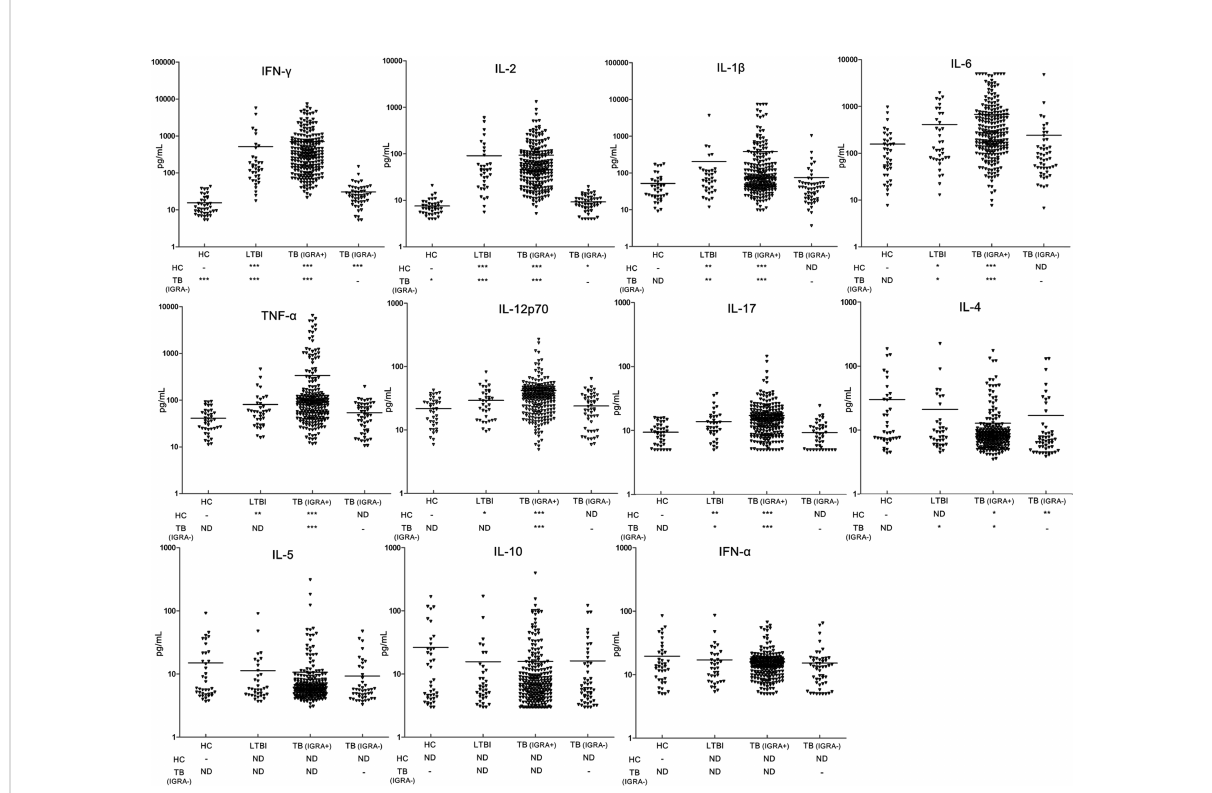
FIGURE 1 Comparison of the concentration of multiple cytokines induced by MTB-speci fi c antigens between groups. Levels of cytokines were detected by using Luminex xMAP technology in supernatant of PBMCs from patients with IGRA-positive TB group (TB (IGRA+), n=221), IGRA-negative TB group (TB (IGRA-), n=50), individuals with latent TB infection (LTBI, n=36), and healthy controls (HC, n=39). The data are represented as scatter plots with each triangular representing a single individual. Statistical differences were analyzed using Wilcoxon rank-sum test; * P< 0.05, ** P <0.01 and *** P